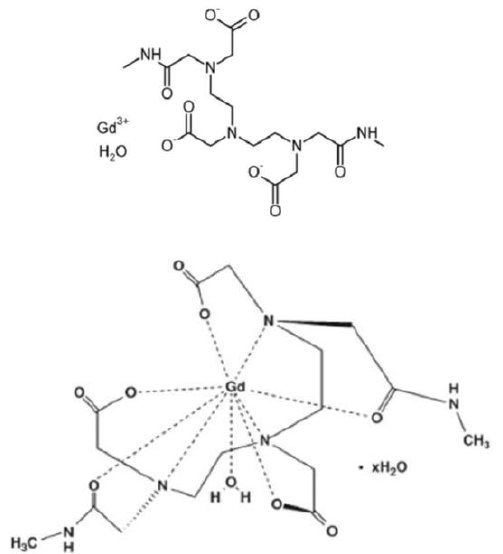
Figure 6. Structure of Omniscan, Gd(DTPA-BMA)(H 2 O).